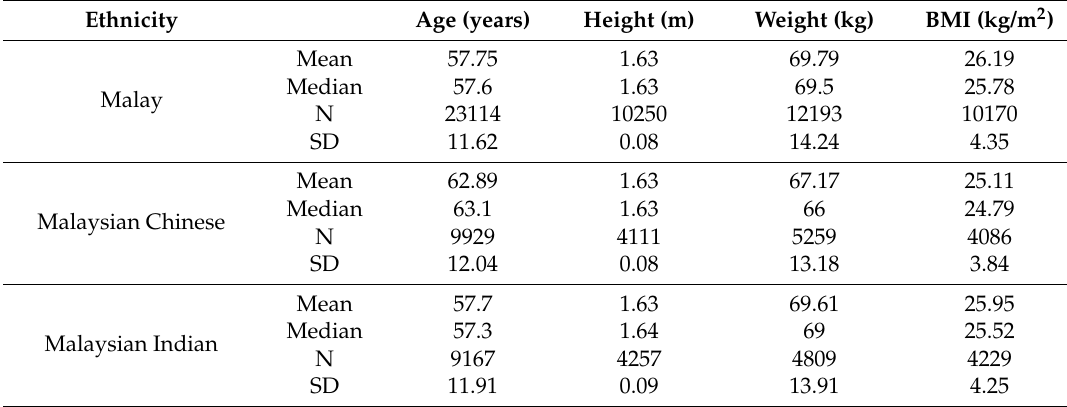
Table 1. Summary demographic data from the NCVD database.